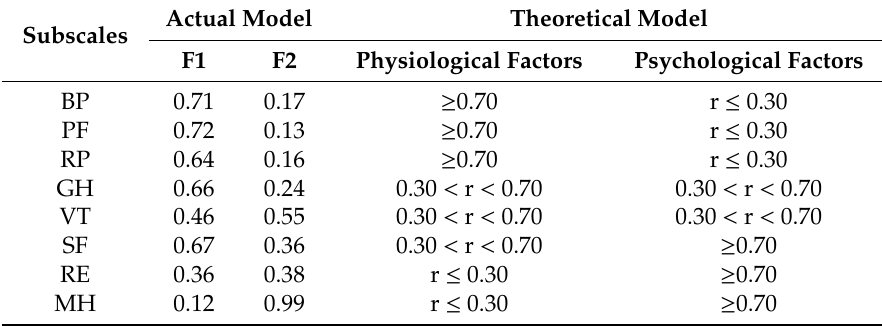
Table 5. SF-36 practical and theoretical model factor load.